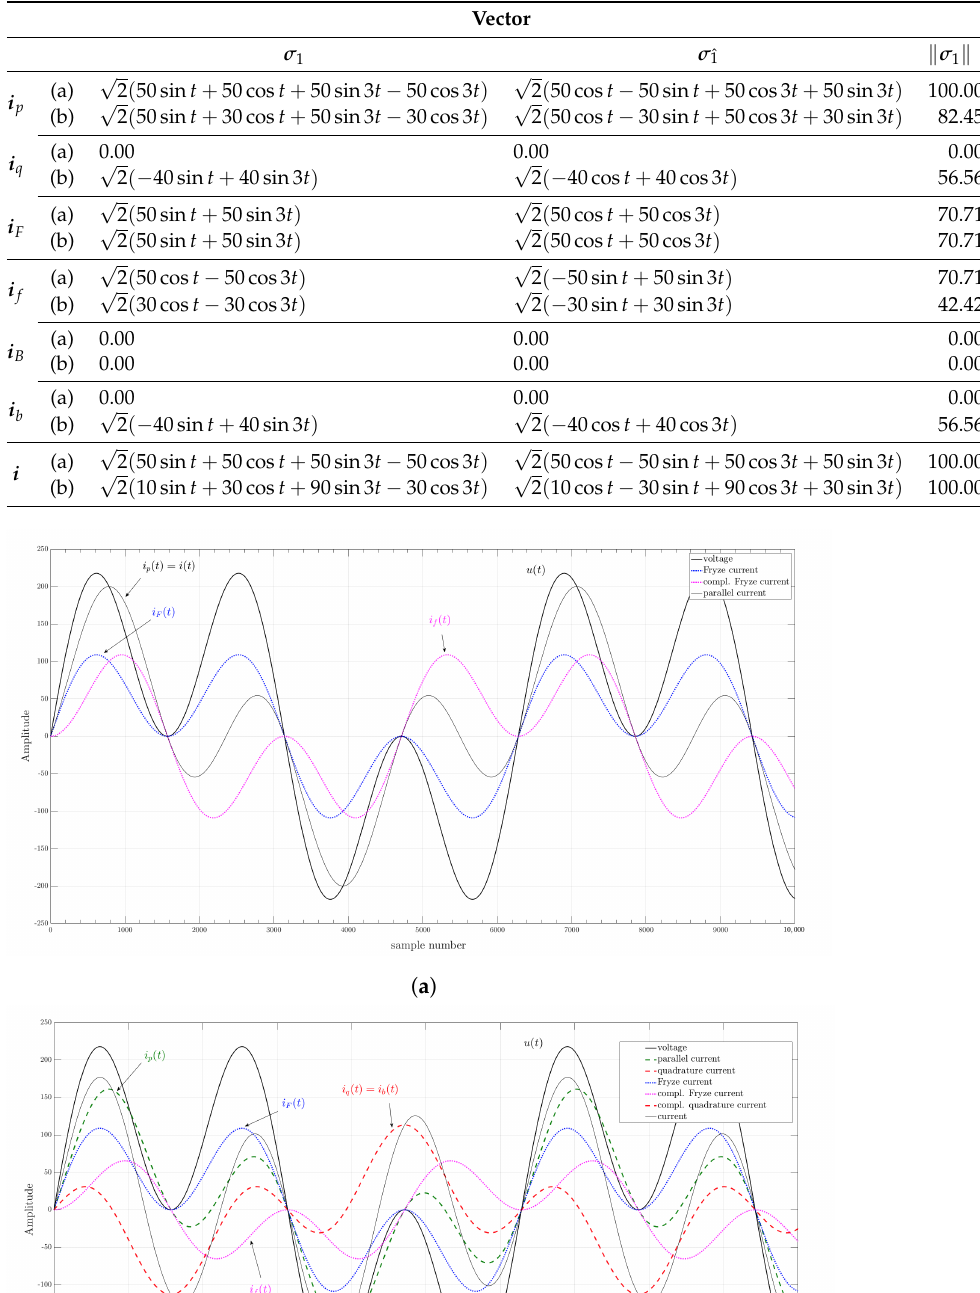
Table 1. Current decomposition for circuit in Figure 2. The column for component σ 1 represents the real current in the circuit while σ ˆ1 is the quadrature signal after applying the HT. The last column accounts for the RMS value of the real current.